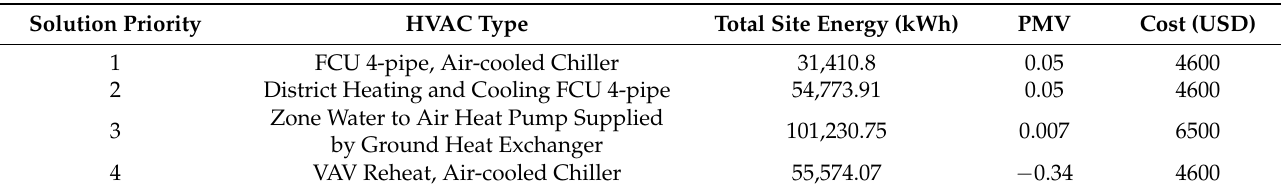
Table 7. HVAC systems used in 2080 weather